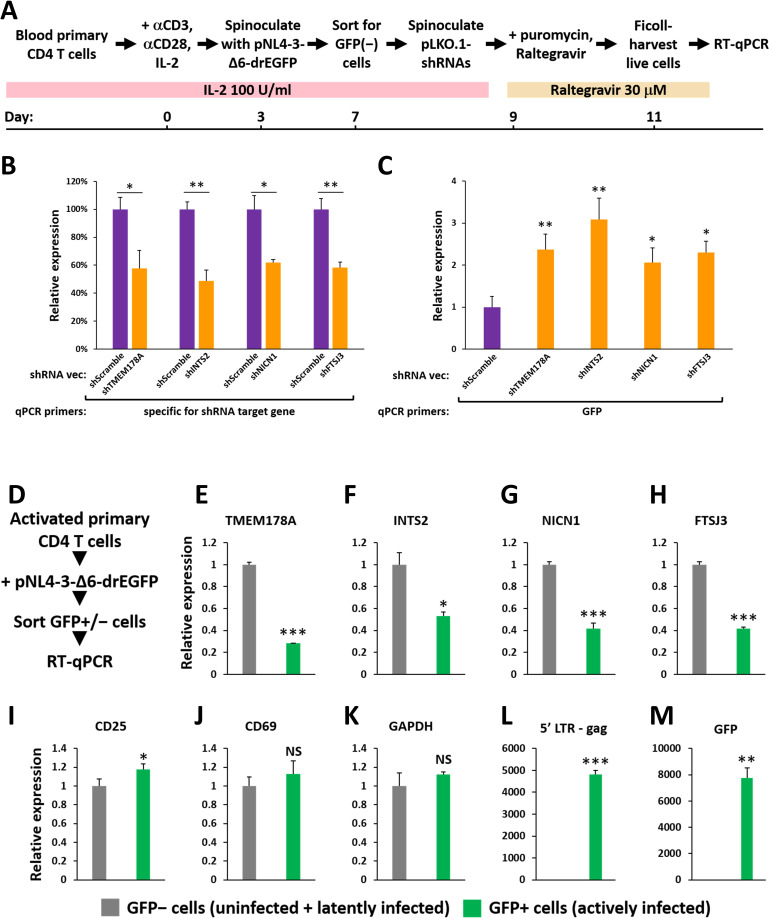
Host Latency Promoting Factors, FTSJ3, INTS2, NICN1, and TMEM178A, Contribute to HIV Latency in Primary Human CD4 T Cells.A. & D. Schematic summaries of the protocols used for testing the function of host factors in maintaining HIV latency (A) and correlation of the expression levels of these host factors with the ability of primary CD4 T cells to support active HIV infection (D). B., C., E., F., G., H., I., J., K., L., & M. RT-qPCR analyses of the mRNA levels of the genes that are denoted by their corresponding qPCR primers or are labeled on top of the panel. In panels B–C, the mRNA level detected in the shScramble-transduced cells was set to 1; in panels E–M, mRNA level detected in the GFP− cells was set to 1. Error bars represent mean +/− SD from three experimental replicates. Asterisks denote levels of statistical significance calculated by two-tailed Student’s t-test (*: p<0.05, **: p<0.01, and ***: p<0.001).